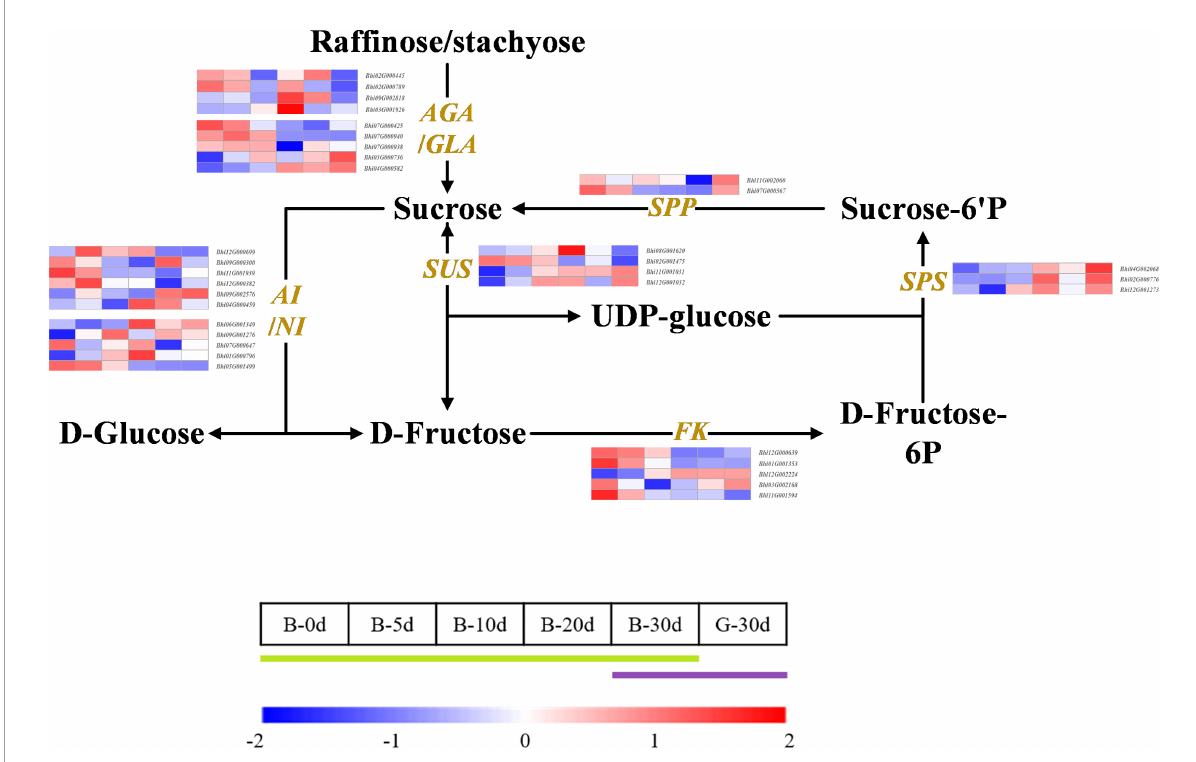
FIGURE3 Developmental expression profiles of genes of sugar metabolism in developing wax gourd fruit. AGA/GLA : alkaline/acid α -galactosidase; AI/NI: acid/neutral invertase; SPP: sucrose-phosphatase; SPS : sucrose phosphate synthase; SUS : sucrose synthase; FK: fructokinase.